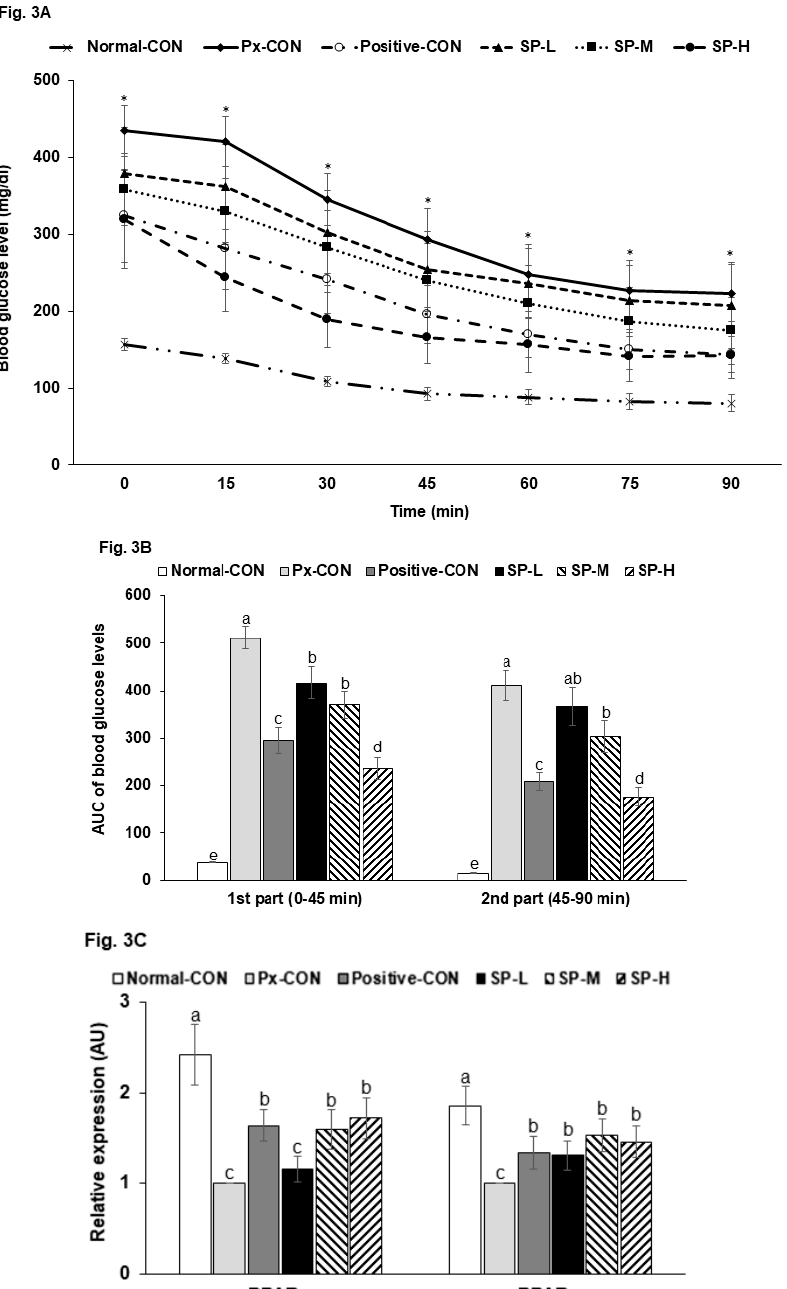
Figure 3. Serum glucose levels during intraperitoneal insulin tolerance testing (IPITT) after a 6 h fast. ( A ). Changes in serum glucose concentrations after an intraperitoneal injection of 1 IU of insulin/kg. ( B ). Area under the curve (AUC) for serum glucose concentrations during the first (0–30 min) and second phases (30–90 min) of IPITT. ( C ). Relative mRNA expression of PPAR- α and PPAR- γ in the liver. Bars or dots and error bars represent means ± SDs ( n = 10). * indicates a significant intergroup difference ( p < 0.05). a,b,c Different letters on bars indicate significant differences ( p < 0.05).